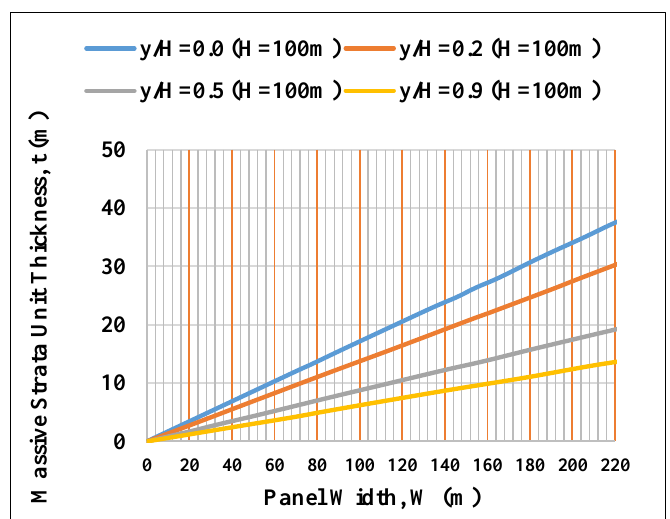
Figure 4: ACARP empirical model for predicting SRP above panels with cover thicknesses between 50 and 150m.